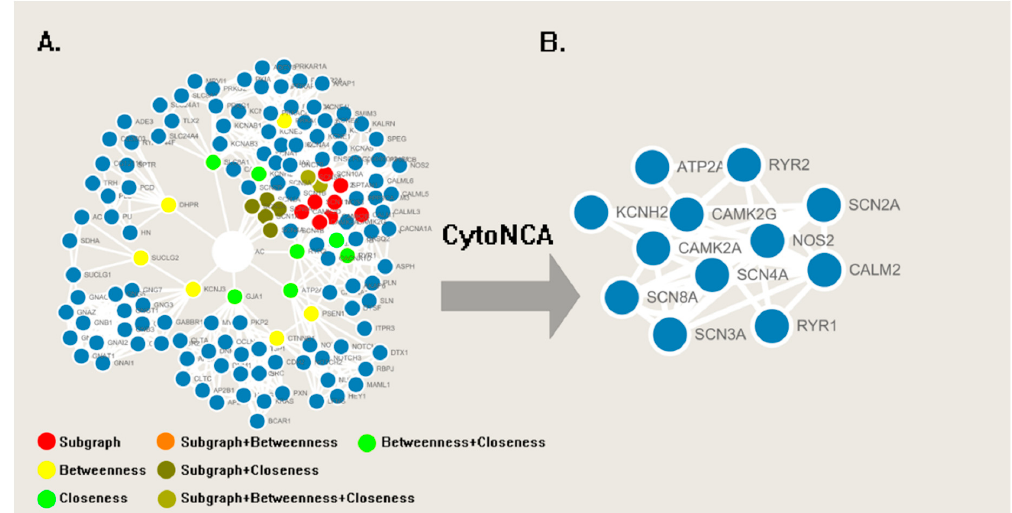
Figure 4. ( A ) The PPI network of proteins about cardiotoxicity induced by aconitine alkaloids. ( B ) The sub-network with essential protein generated from the Cytoscape and CytoNCA plugin.